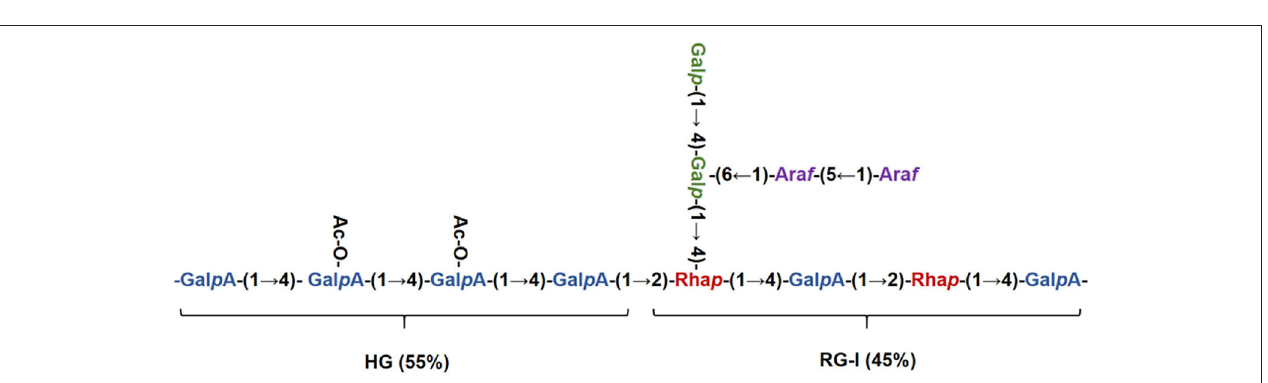
as the hepatocytes injuries (28). When compared with the blank control, the 2 µ g/ml LPS in the positive control group significantly increased NO secretion from RAW264.7 cells after 24 h. Cells were pre-treated with polysaccharides for 1 h and